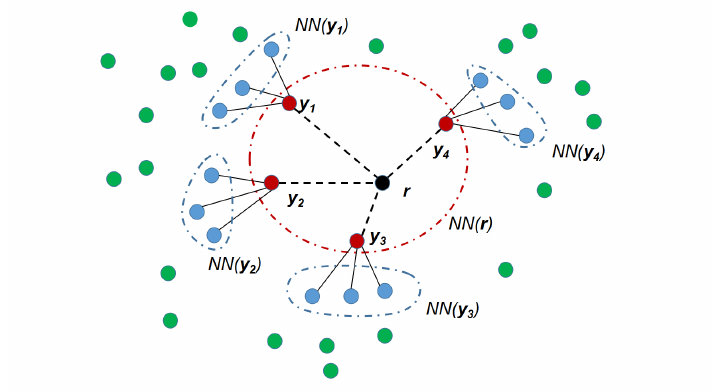
Figure 2. A graphical representation of considering two layers of neighborhoods for a given measurement r . The data points in red correspond to the first layer neighbors, and the data points in blue correspond to the second layer neighbors. The data points in green are outside the two layers of neighborhoods of r . In this example, the first layer was selected with neighborhood size J = 4 and the second layer was selected with neighborhood size K =